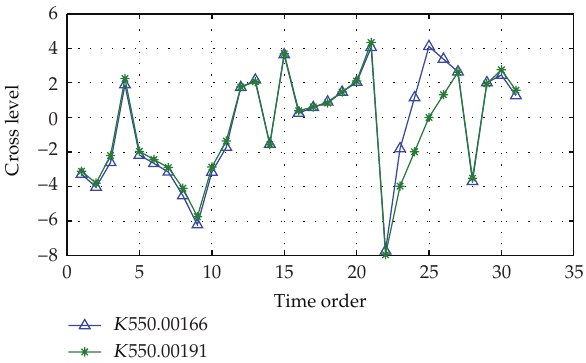
Figure 1: Comparison of track cross level values at K550.00166 and K550.00191 mileage points.